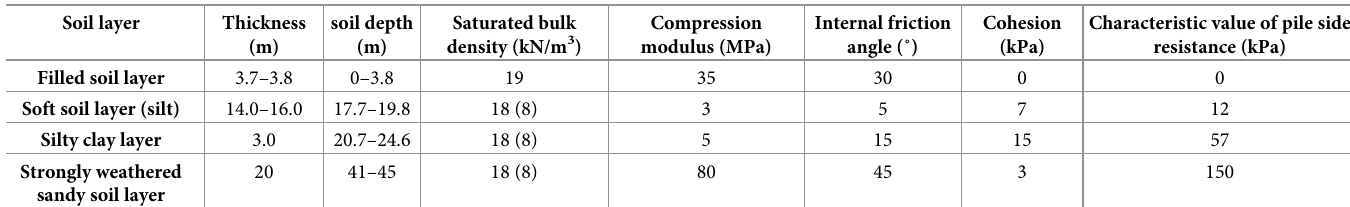
Table 1. Soil distribution and mechanical properties.